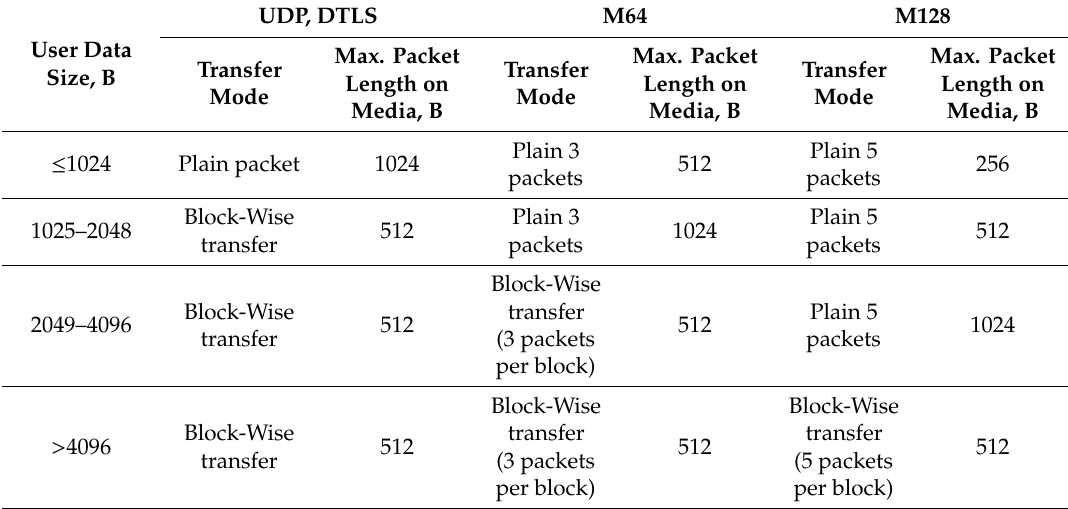
Table 1. Data transfer mode used in various cases of transport protocol and user data